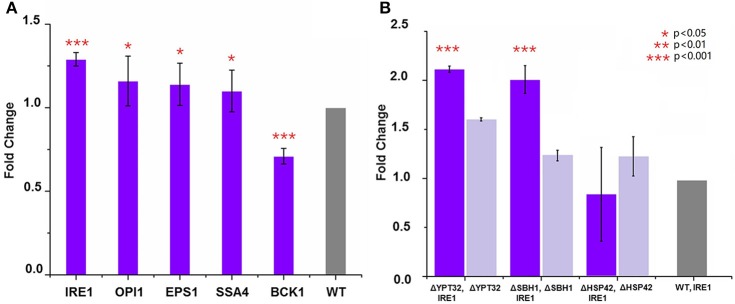
(A) Overexpression of genes that led to the lowest HBsAg expression and evaluation of their impacts on HBsAg expression. The wild-type BY4741 strain was co-transformed with the HBsAg-GFP plasmid and the plasmid harboring the target gene (IRE1, OPI1, EPS1, BCK1, or SSA4). Each data point represented the mean of biological triplicates and the fluorescence was normalized by OD600. The error bars corresponded to standard deviation. Student's t-test was used to calculate the p-values and we considered two samples were statistically different if p < 0.05. (B) Synergistic effects of gene knockout and gene overexpression on HBsAg expression. The yeast knockout strains ΔHSP42, ΔSBH1, and ΔYPT32 were co-transformed with the HBsAg-GFP plasmid and the IRE1 overexpression plasmid. The yeast knockout strains ΔHSP42, ΔSBH1, and ΔYPT32 that were transformed with the HBsAg-GFP plasmid were used as control strains. Significance was calculated by comparing the knockout strains that also overexpressed IRE1 with ones without IRE1 overexpression. All the data was refactored to the wild type strain as fold change. The p < 0.001 was marked with three asterisks; p < 0.01 was marked with two asterisks; and p < 0.05 was marked with one asterisk.